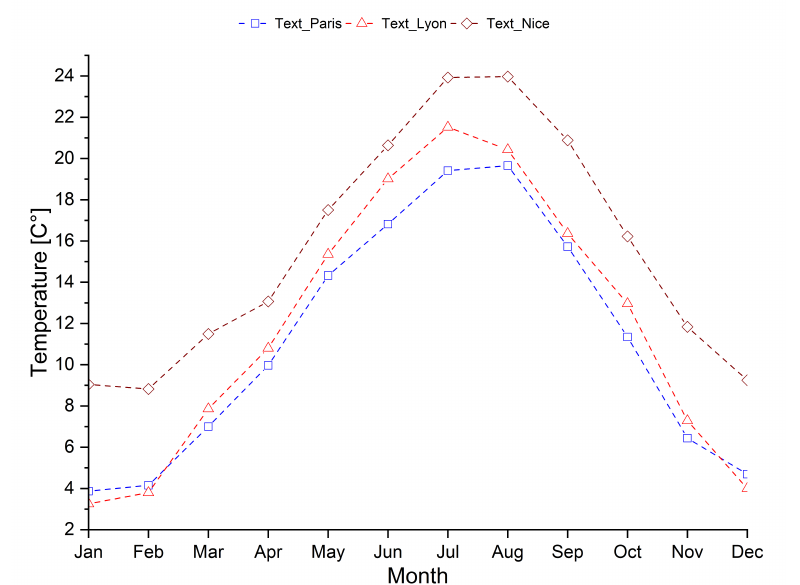
Figure 5. Monthly average outdoor temperatures for the weather of Paris-Orly, Lyon, and